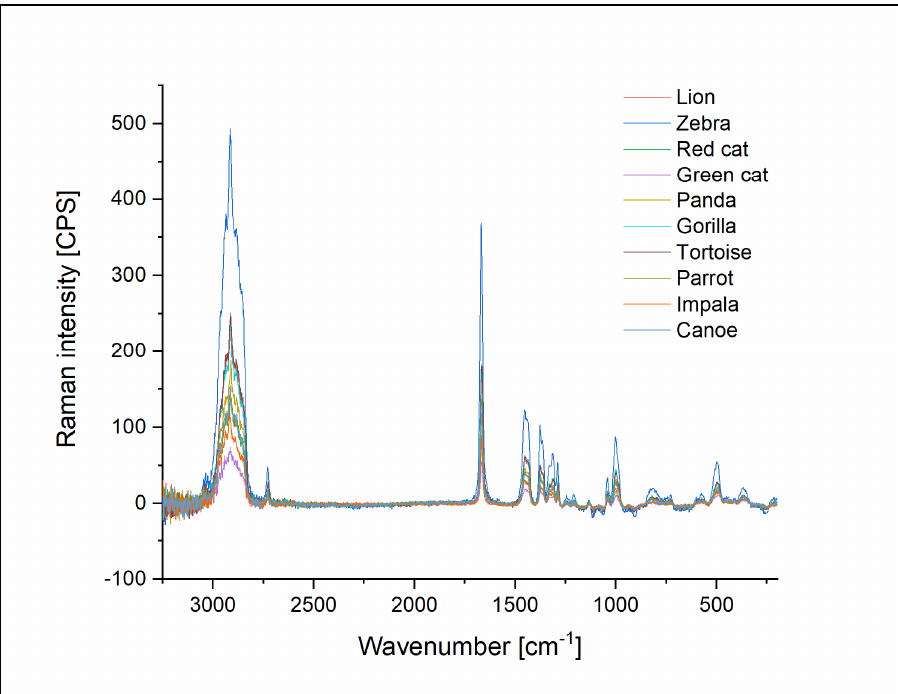
Figure 9. Raman spectra of all latex ligatures with identical peaks show that there is no significant difference between the latex ligatures.